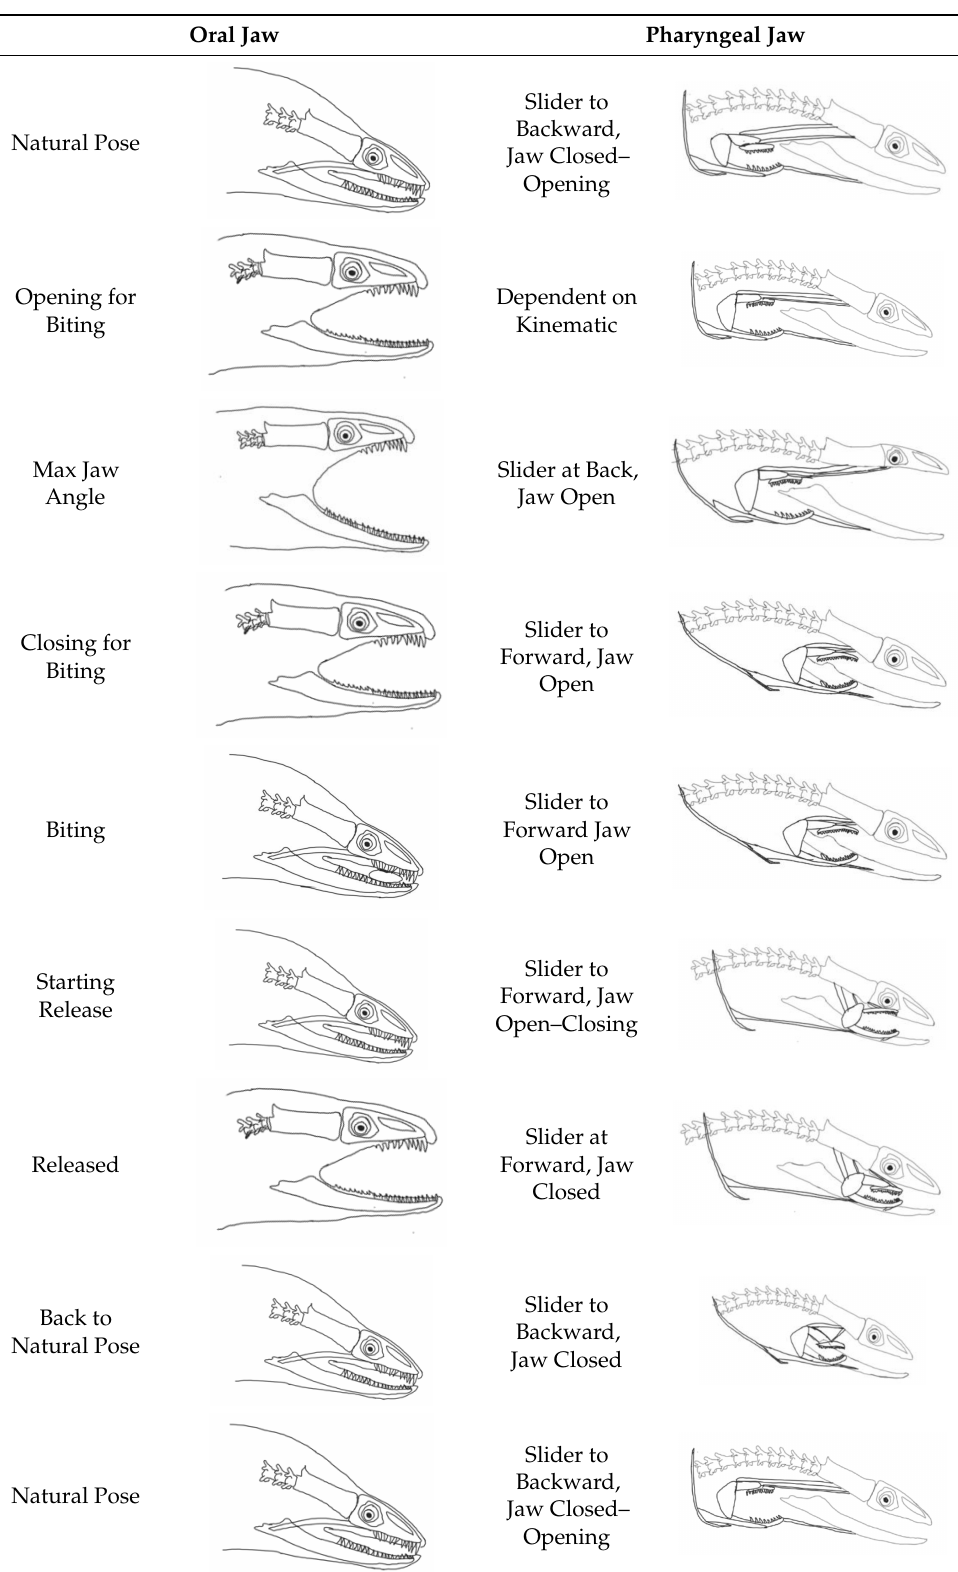
Table 1. Approximation of the different poses of the oral jaw and the pharyngeal jaw during